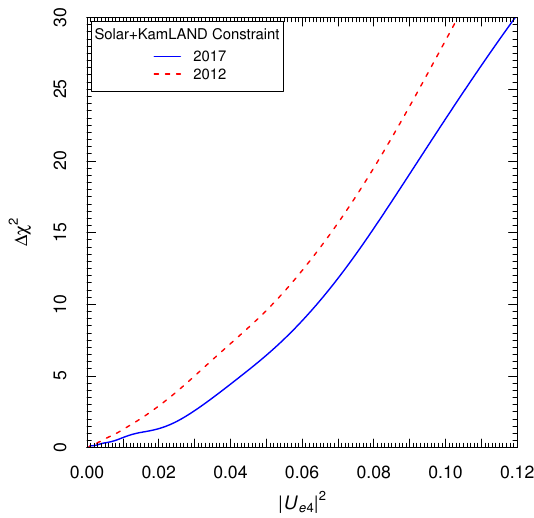
Figure 4 . Marginal (cid:1) (cid:31) 2 = (cid:31) 2 (cid:0) (cid:31) 2 as a function of sin 2 2 # ee obtained from the (cid:12)t of current min solar+KamLAND neutrino data (2017) compared with the one obtained in 2012 in ref. [7].